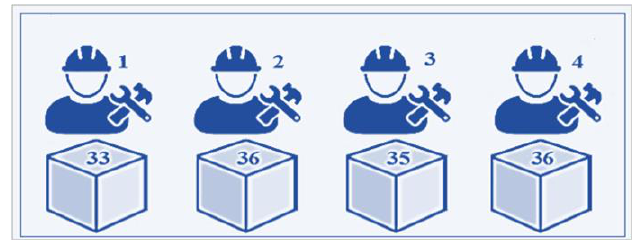
Figure 9. The total number of tasks assigned to each technician. The daily busy time for executing tasks for facility services by each technician are stated in Table 7. The total hours from technicians over 12 days are presented in Figure 10. The optimal schedule for completing tasks over 12 days is presented in Table